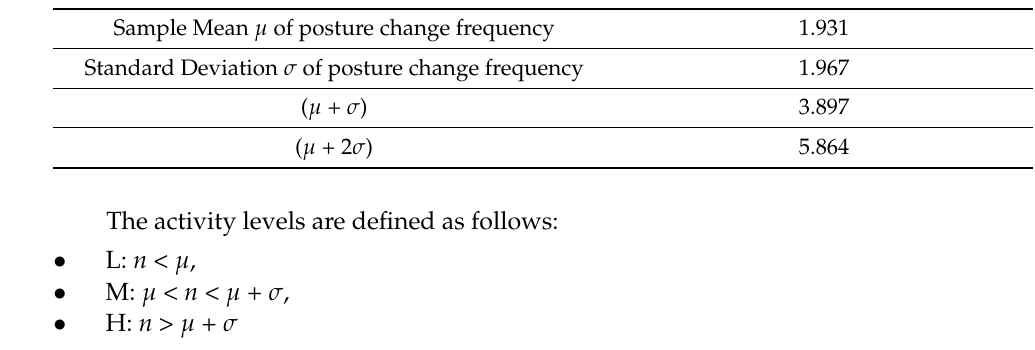
Table 3. Sample posture changes data in experiment.